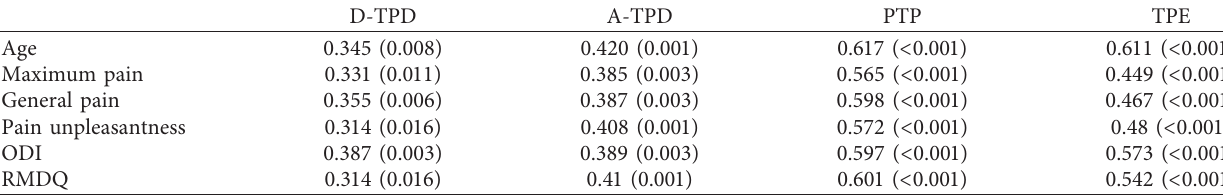
Table 2: The correlations among age, pain severity, disability, and tactile